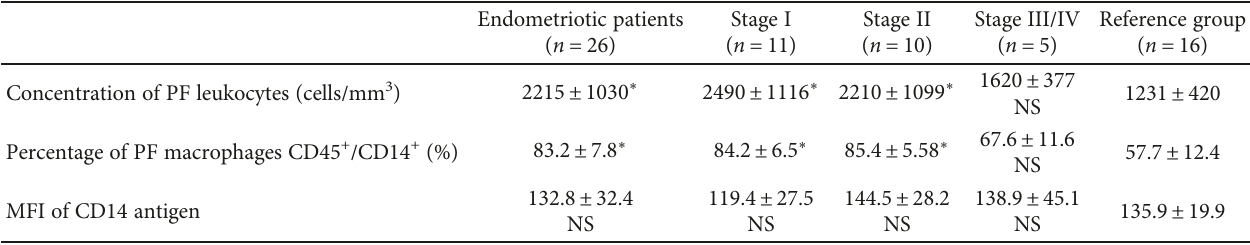
Table 1: The mean ( ± SD) concentration of leukocytes, percentage of macrophages, and MFI of CD14 antigen in peritoneal fl uid. Endometriotic